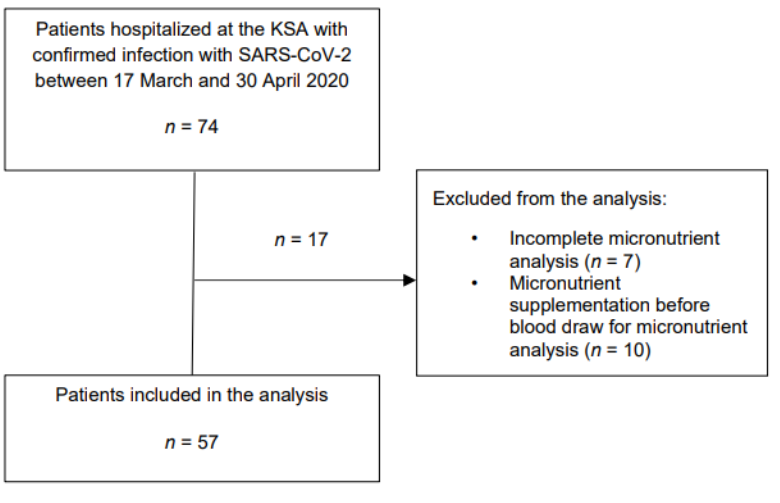
Figure 1. Overview of the study flow. Table 1. Baseline characteristics and micronutrient levels stratified by number of micronutrient